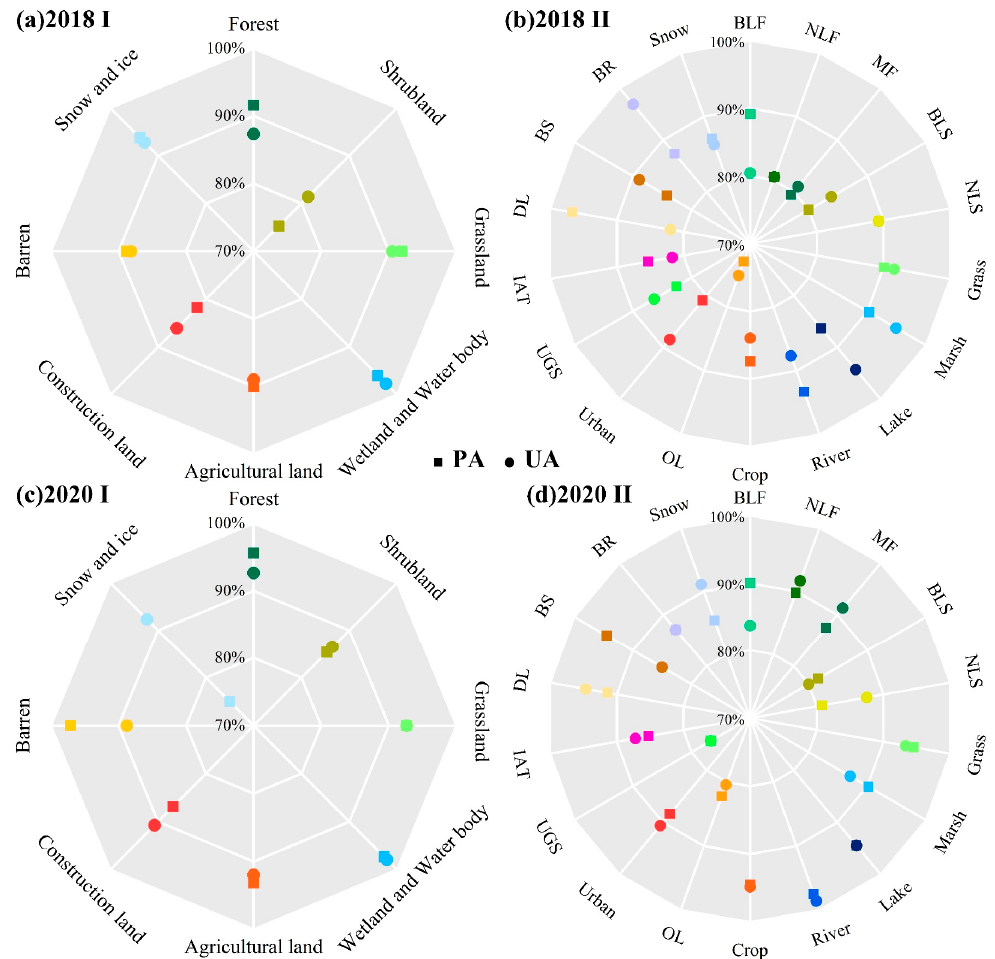
Figure 7. Producer’s accuracy (PA) and user’s accuracy (UA) for all LULC types: ( a ) first-degree class in 2018; ( b ) second-degree class 2018; ( c ) first-degree class 2020; ( d ) second-degree class 2018 in 2020.